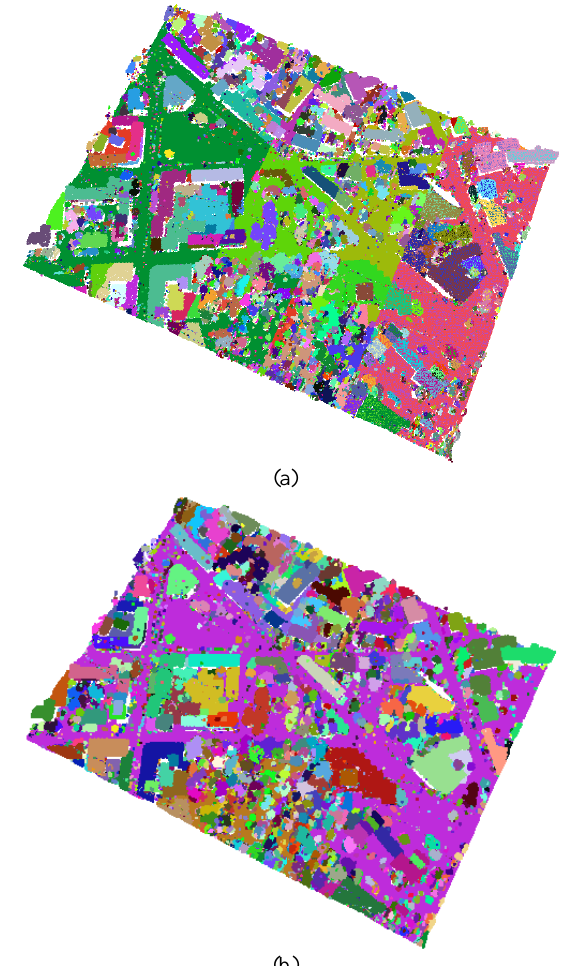
Figure 4 The segmentation of each segmentor window. Unmerged segments (a) and merged segments (b).